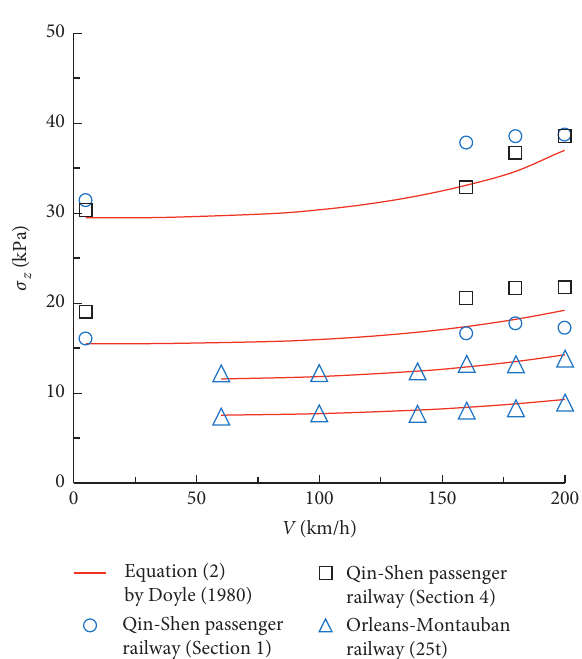
Figure 2: Measured vertical stress amplification caused by train